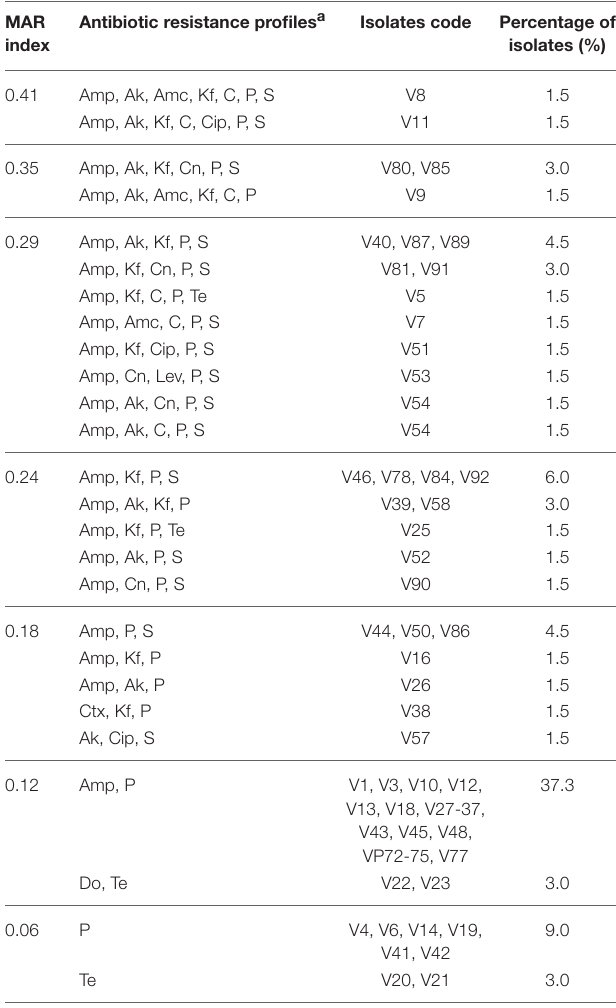
TABLE 5 | Multiple antibiotic resistance (MAR) index value of V. parahaemolyticus isolates from short mackerel